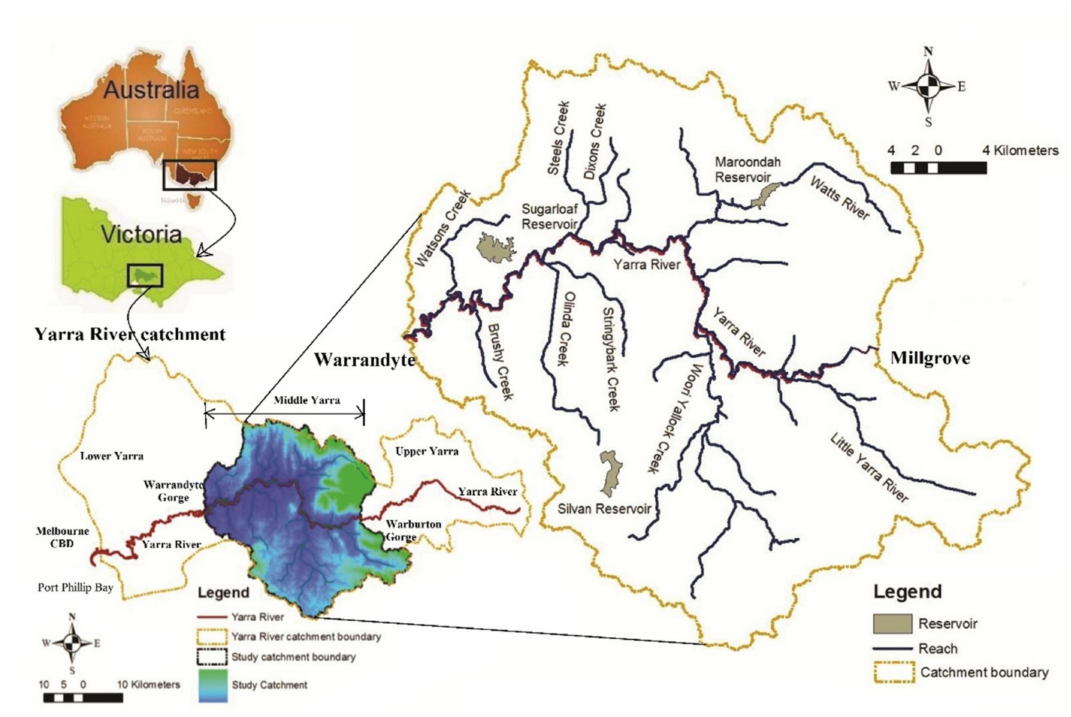
Figure 1. Location of the middle Yarra division [30,31].